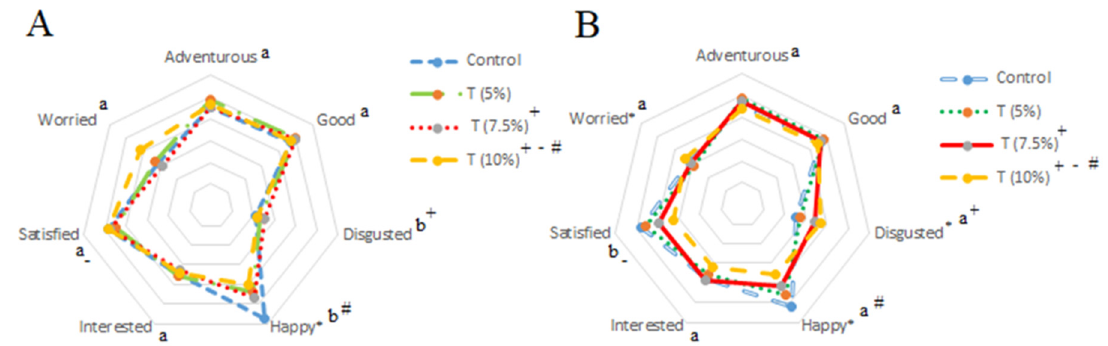
Figure 4. Mean emotion scores elicited by chocolate chip cookies with cricket powder treatments (T) inclusion of 0%, 5%, 7.5% and 10%, respectively. ( A ) Before consumers had been given information about cricket powder health and environmental benefits, and ( B ) after consumers had been given information about cricket powder health and environmental benefits. * Indicates significant difference among mean emotion scores by Tukey test ( p < 0.05). + − # different letters indicate significant differences ( p < 0.05) in emotion scores based on a dependent samples t -test, comparing before and after consumers had been given information about cricket powder health and environmental benefits.